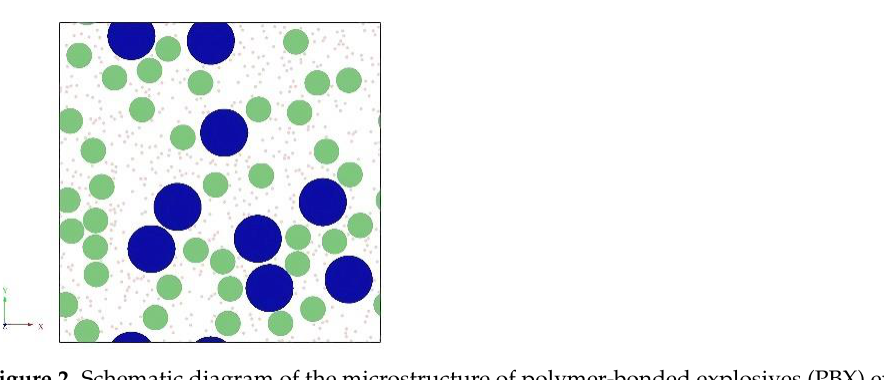
Figure 2. Schematic diagram of the microstructure of polymer-bonded explosives (PBX) explosive material.